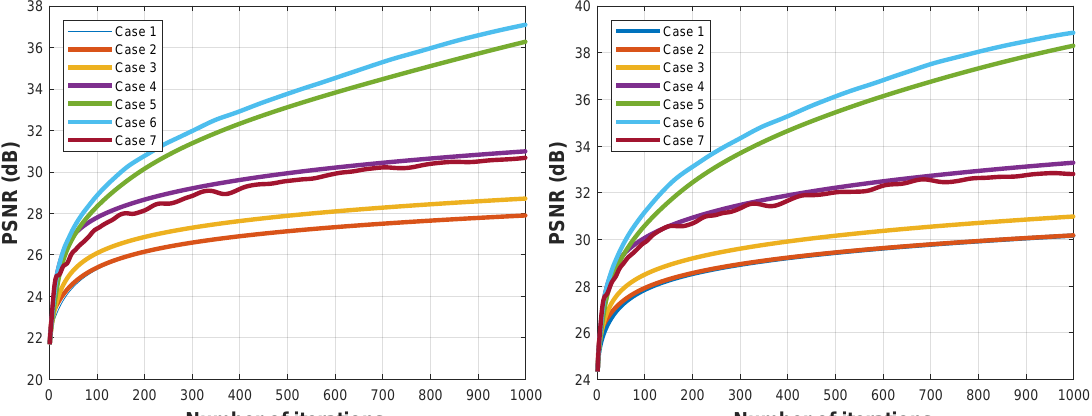
Figure 3. The graphs of PSNR of the FBMWA under different parameters θ n for Cameraman ( left ) and Lenna ( right